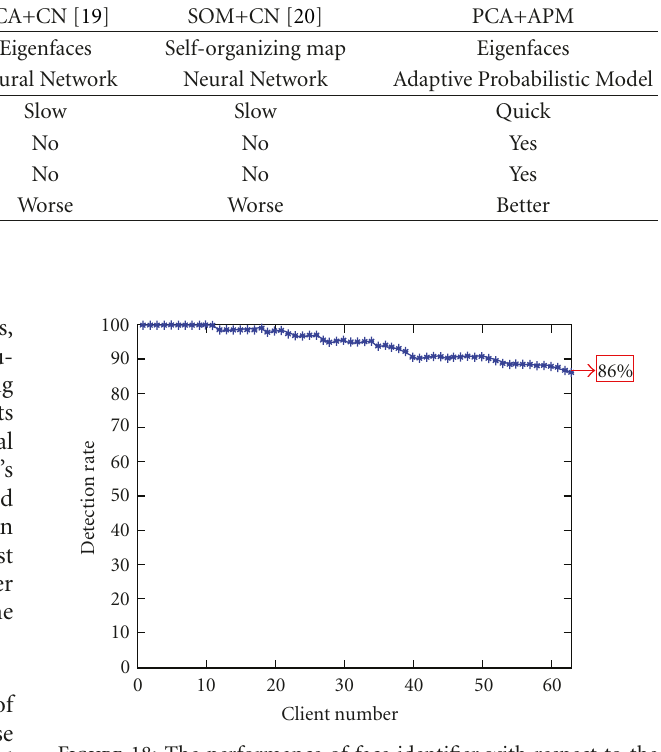
Figure 18: The performance of face identifier with respect to the number of